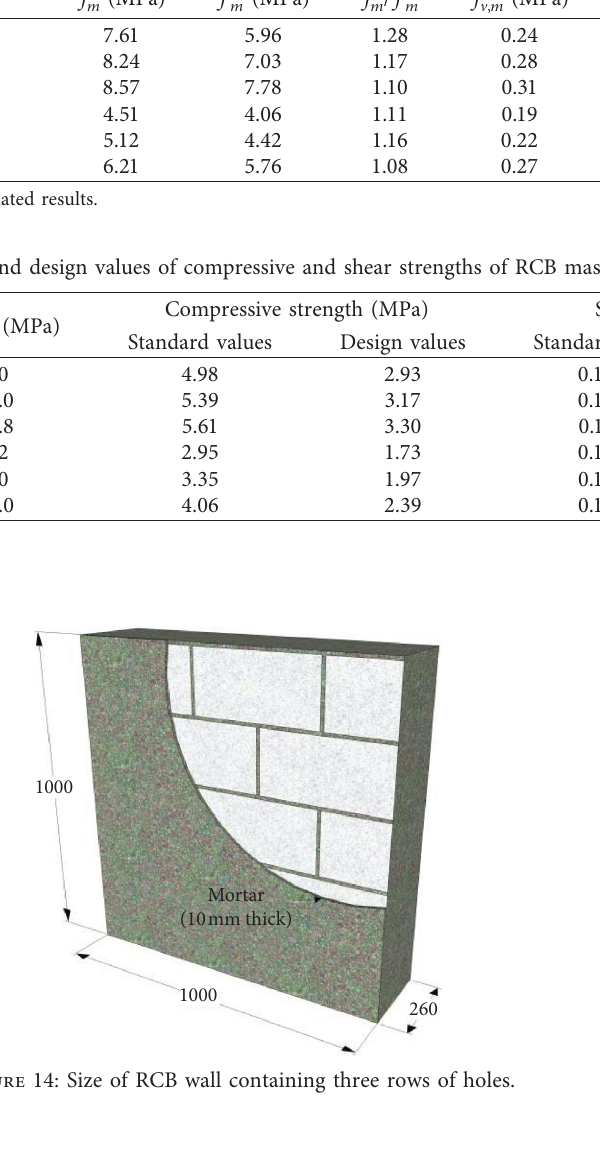
Table 7: Test and calculated results of the RCB masonries’ compressive and shear strengths. Group